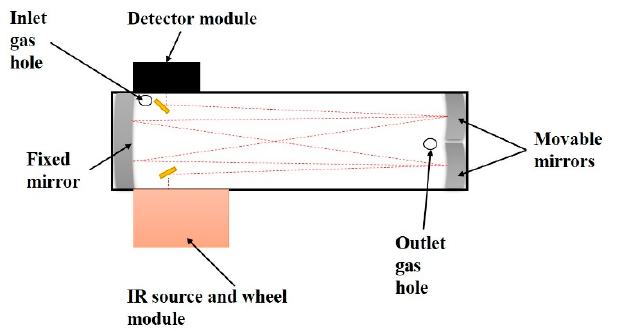
Figure 3. Schematic diagram of the wide-range NDIR with a flexible pathlength. Table 1. Concentrations of target gases used in this study. BTEX: benzene, toluene, ethylbenzene and xylene.